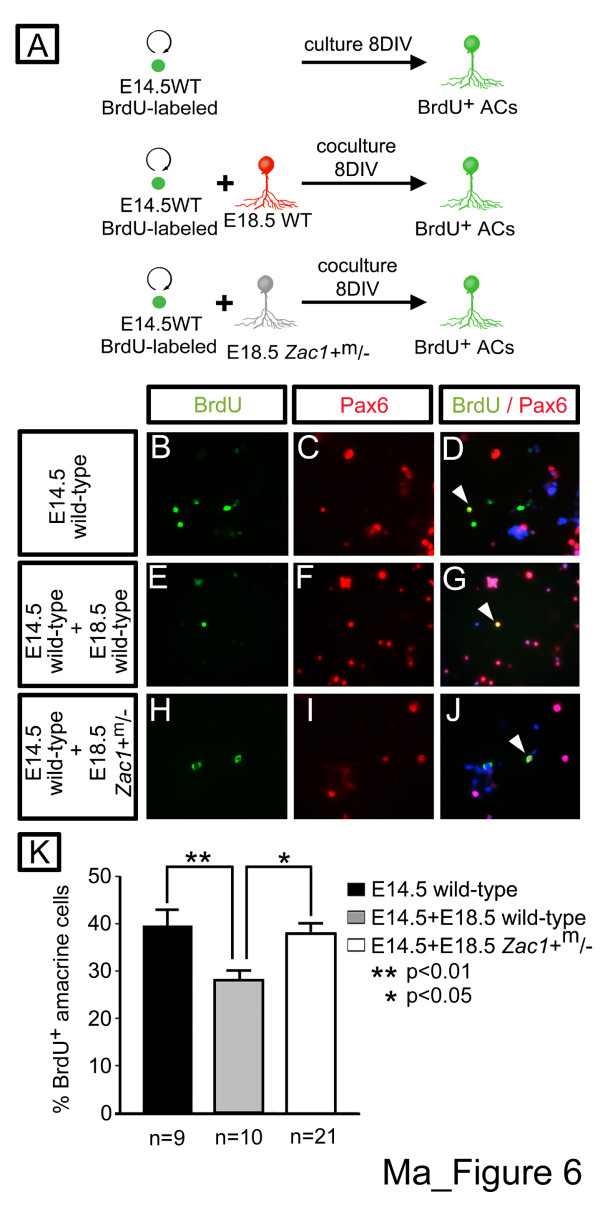
Zac1+m/- retinae lose amacrine cell feedback inhibition. (a) Schematic of aggregation assay protocol. (b-j) Immunolabeling of dissociated cell pellets with Pax6 (red (c,d,f,g,i,j)), BrdU (green (b,d,e,g,h,j)) and merged image with DAPI (blue (d,g,j)). E14.5 progenitors cultured alone (b-d) or with E18.5 wild-type (e-g) or Zac1+m/- (h-j) retinal cells. Arrowheads mark Pax6/BrdU double+ nuclei (d,g,j). (k) Percentage of BrdU+ E14.5 cells that differentiated into Pax6+ amacrine cells when cultured alone (black bar; 1,085 BrdU/Pax6 double+/2,892 BrdU+) or with E18.5 wild-type (grey bar; 853 BrdU/Pax6 double+/3,215 BrdU+) or Zac1+m/- (white bar; 2,559 BrdU/Pax6 double+/7,196 BrdU+) retinal cells. n indicates number of individual retinal aggregates quantified.